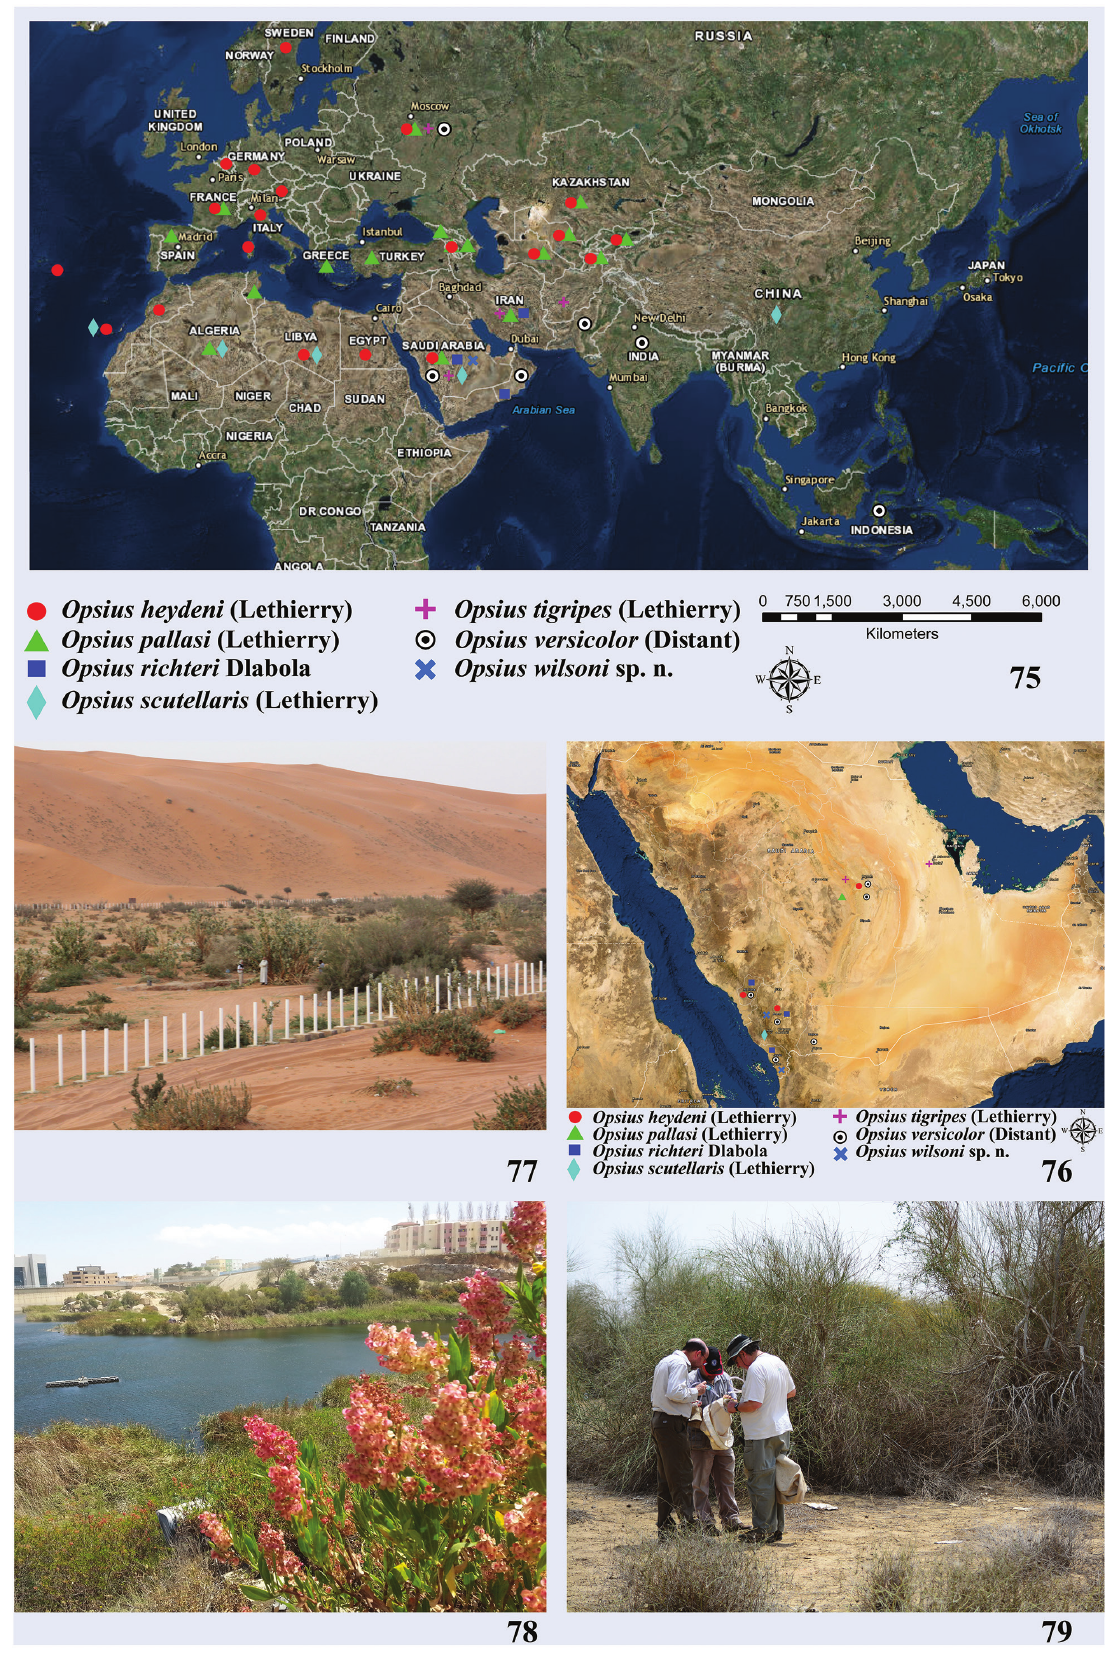
Figures 75–79. 75, 76. Distribution of Opsius spp. 75. World distribution (point indicates presence in the country). 76. Local distri- bution; 77–79. Habitats of Opsius spp. 77. Locality: Muzahimiyah, Al Khararah: 24°24.35'N, 46°14.67'E; 78. Locality: Abha, Sad Abha: 18°19.32'N, 42°31.00'E; 79. Type locality: Jazan, Wadi Jazan: 17°01.275'N,